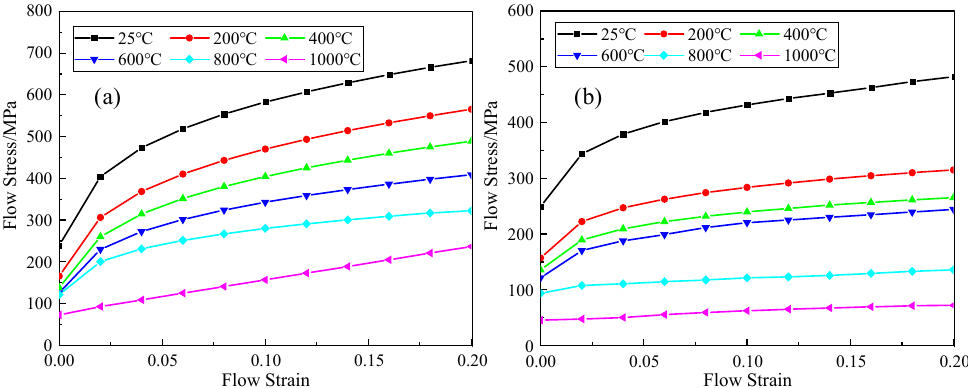
Figure 3. Real flow stress-strain curve. ( a ) 316L; ( b ) Q235B.